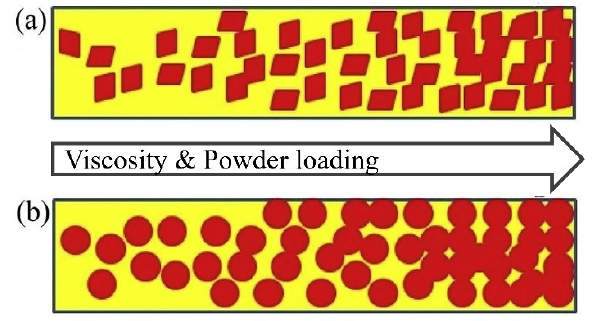
Figure 2. The influence of powder particle shape on viscosity: ( a ) non-spherical particles; ( b ) spherical particles. Reproduced with permission from reference [74], copyright © 2020, Elsevier B.V.